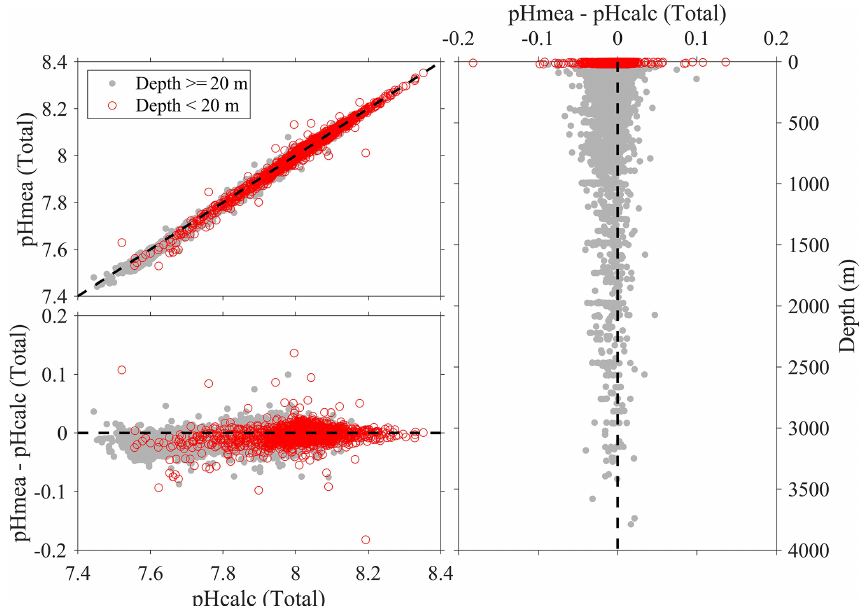
Figure 9. Comparison plots of in situ pH (total scale) that is measured using spectrophotometers (pHmea) and in situ pH (total scale) that is calculated from DIC and TA and other parameters